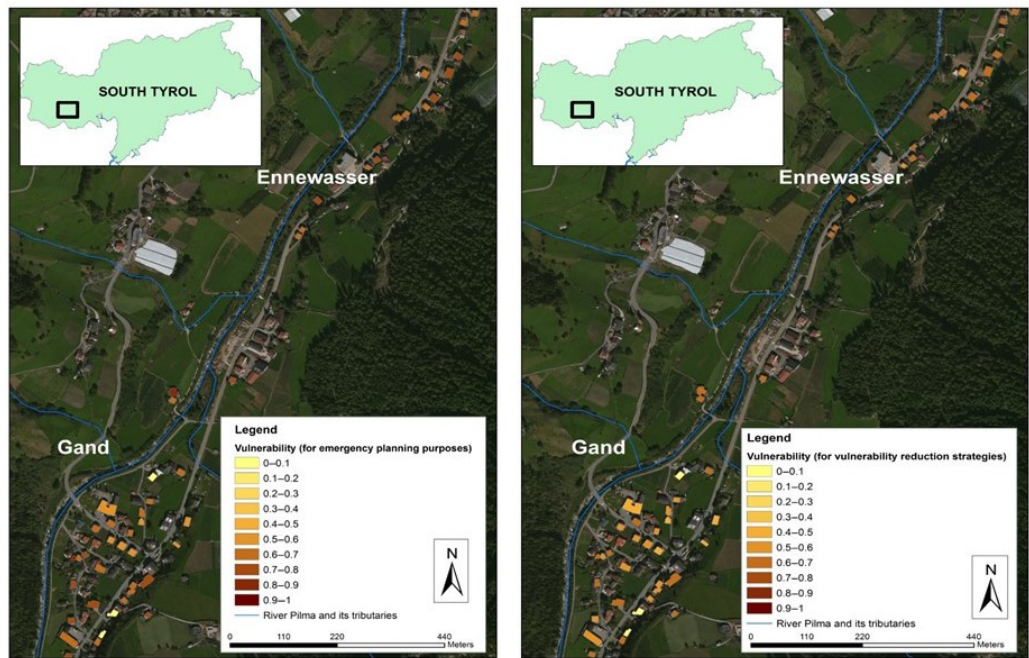
Figure 8. The spatial distribution of physical vulnerability using indicators for emergency planners (left panel) and for vulnerability reduction strategies (right